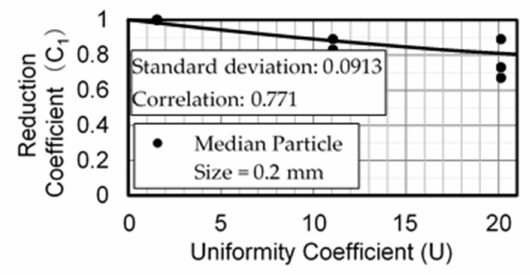
Figure 6. Influence of the uniformity coefficient to the bed-load reduction coefficient (the median grain size is 0.2 mm; dry densities are around 1.5 g/cm 3 ).